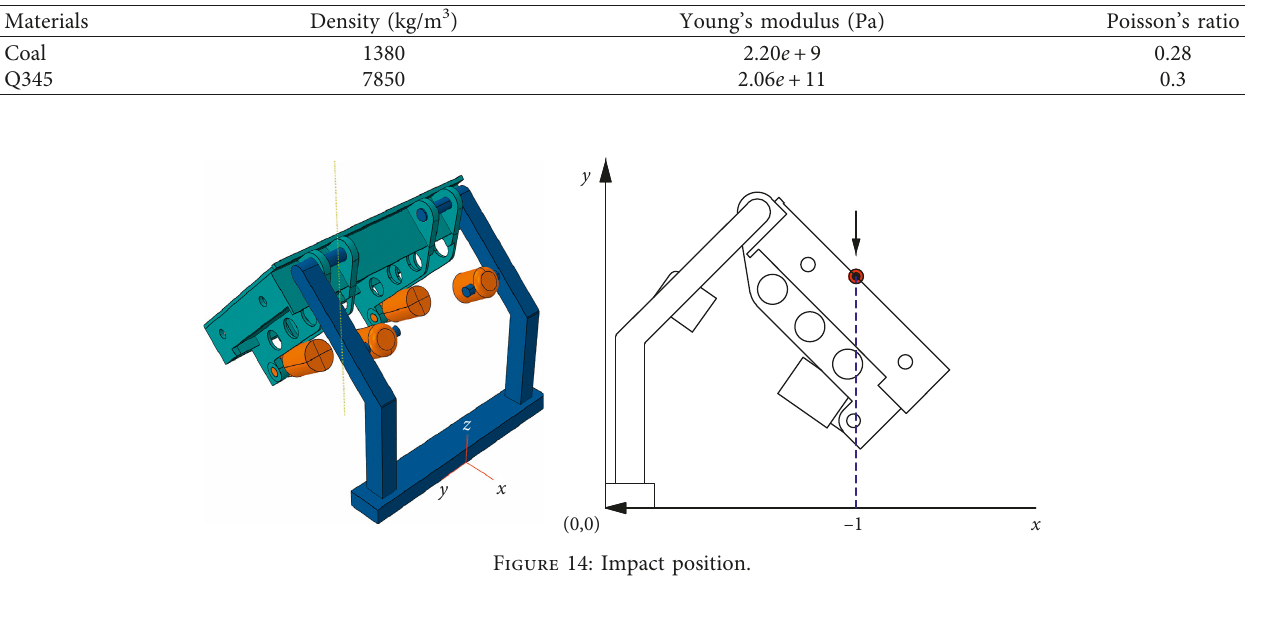
Figure 13: Dimension and structure diagram of the jack of the tail beam. Table 1: Parameters of coal particles and Q345.